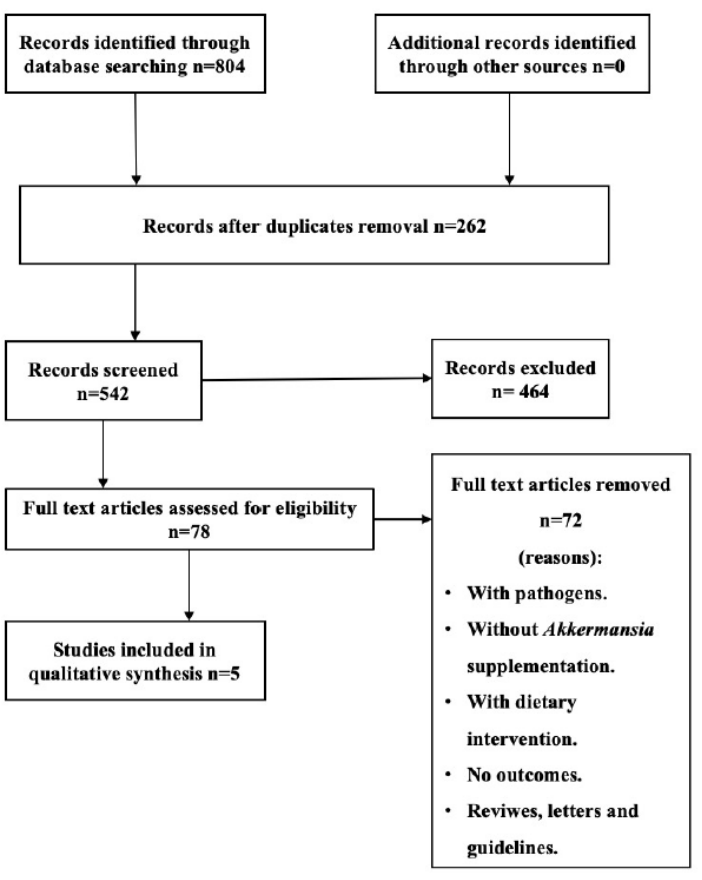
Figure 1. PRISMA flowchart showing the progression of trials through each stage of the selection process.